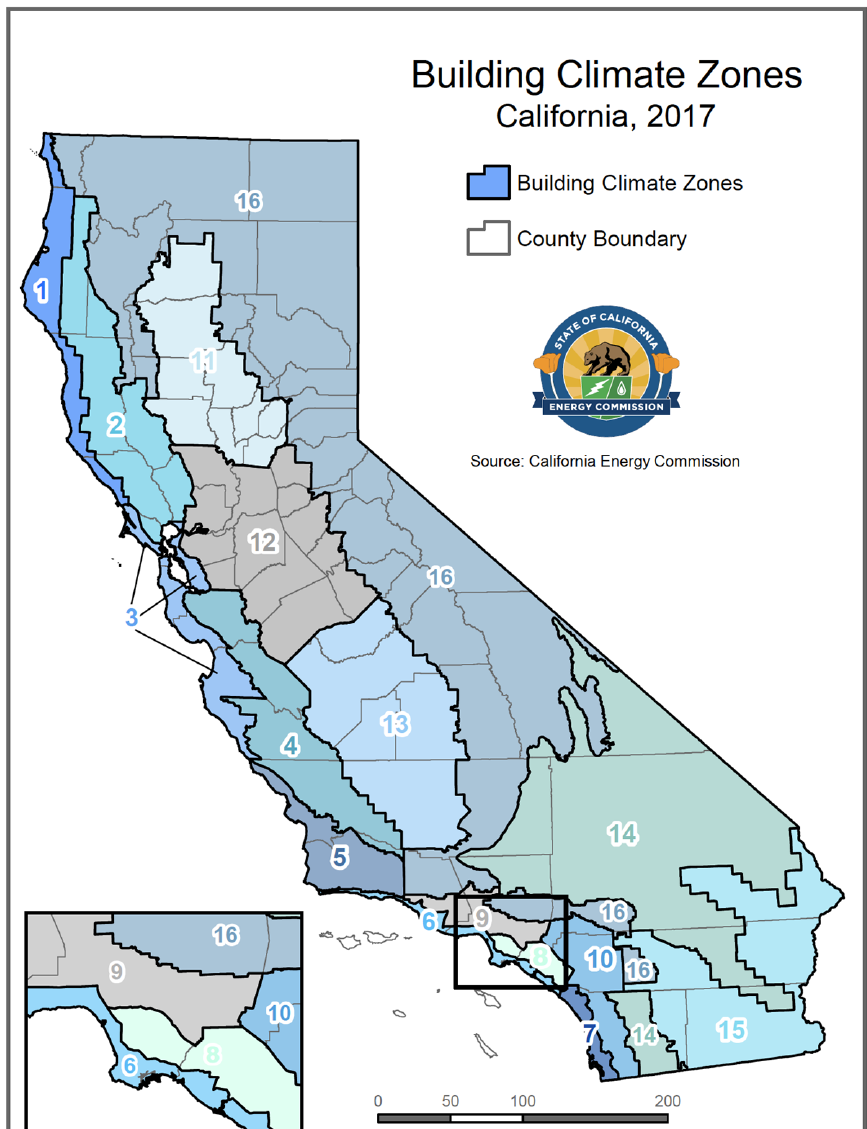
Figure 2. California climate zones.